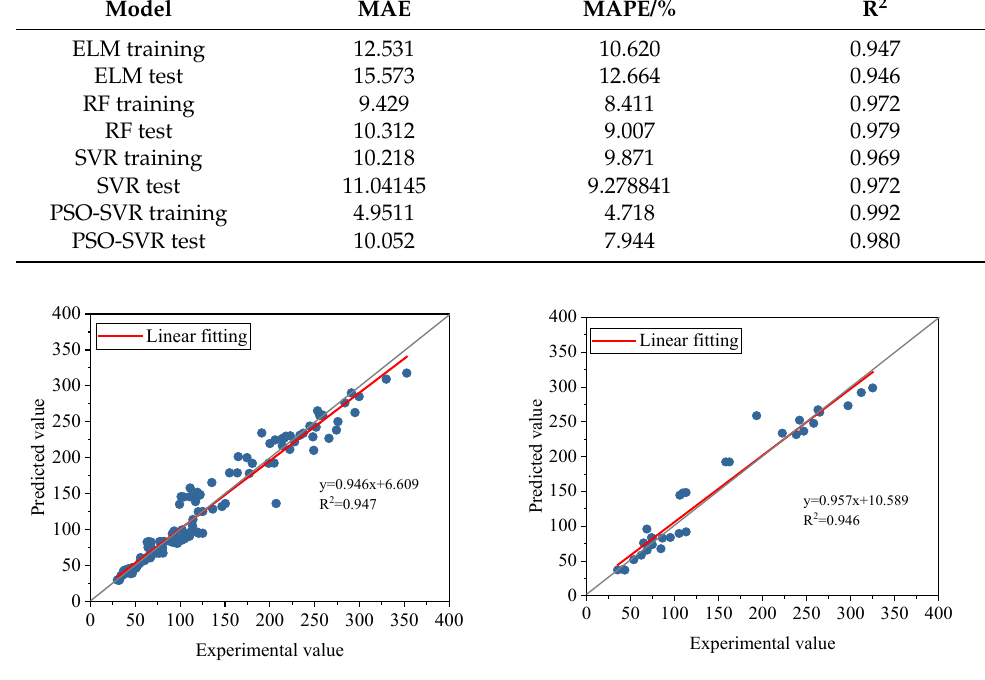
( a ) ELM model prediction results: training set (left), test set (right) Figure 5. Cont